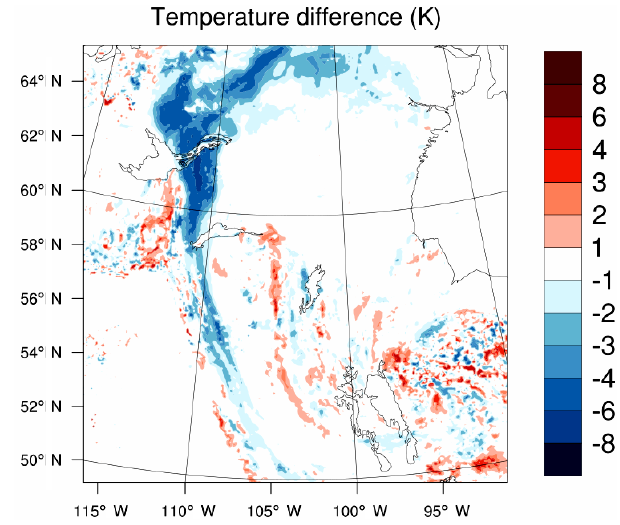
Figure 13. Temperature changes in 2m height at 18:00UTC, 15 July 2010. Displayed is the difference between the simulations VARHEIGHT and